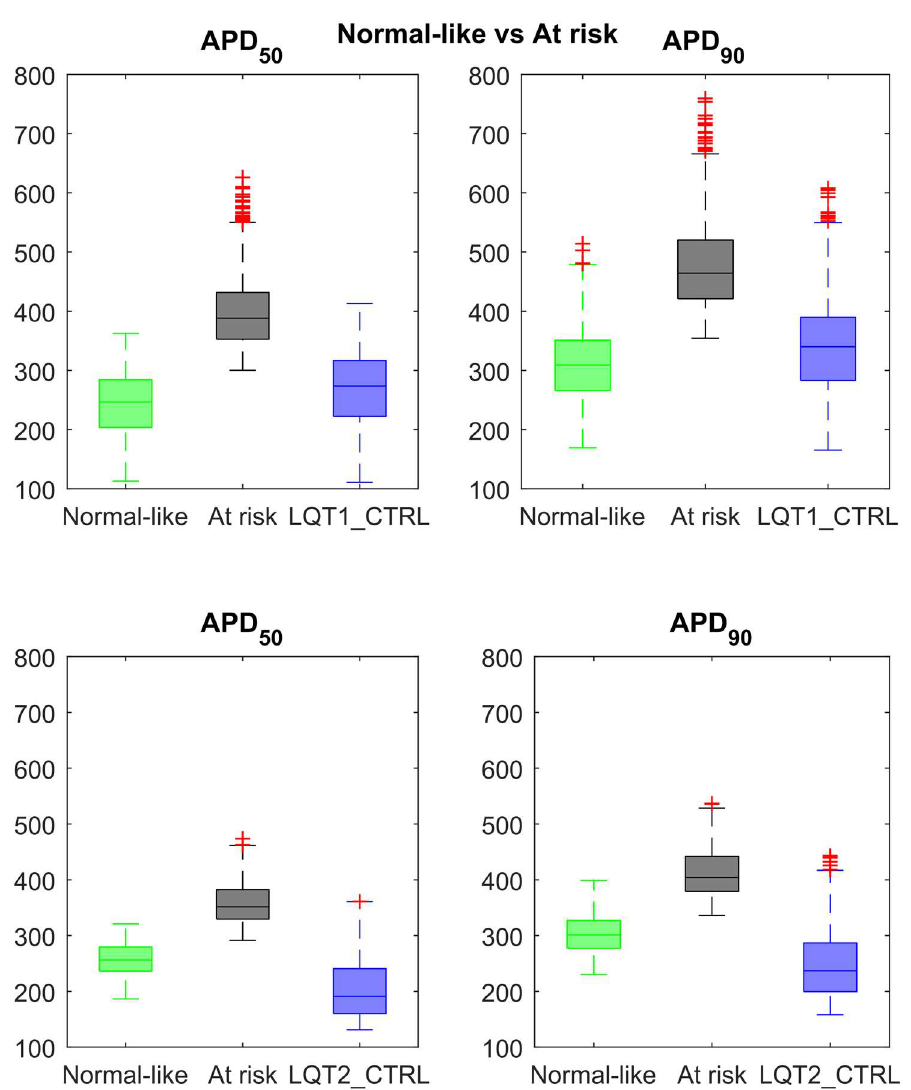
Figure 10. Distribution of APD 50 (green) and APD 90 (black) among the at risk and normal-like groups for the LQT1_MUT ( upper row ) and LQT2_MUT ( lower row ). The AP biomarker distribution in the corresponding control population is reported in blue. Outliers are represented as red crosses.